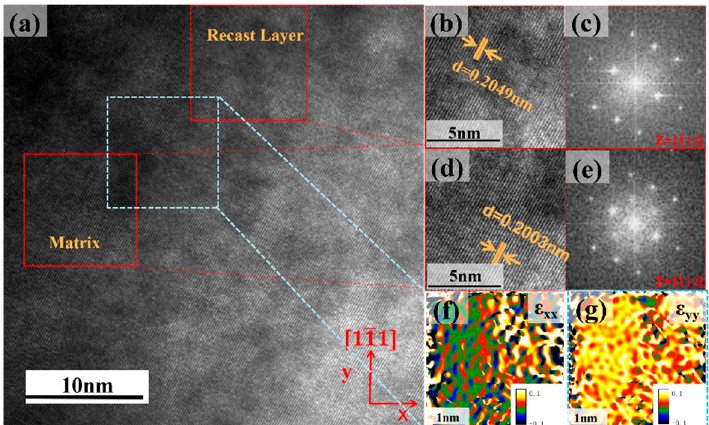
Figure 6. HR-TEM analysis of transition regions: ( a ) HR-TEM image; ( b , c ) HR-TEM and FFT of the recast layer; ( d , e ) HR-TEM and FFT of the matrix; and ( f , g ) geometric phase analysis of transition regions along the x and y directions.